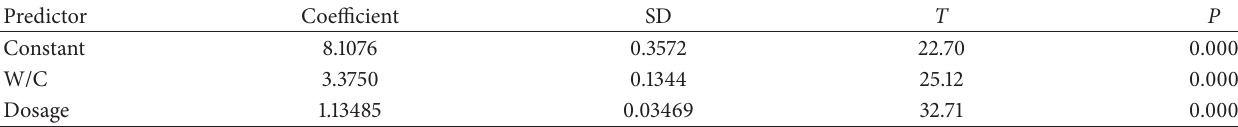
Table 7: Regression analysis on fluidity results.